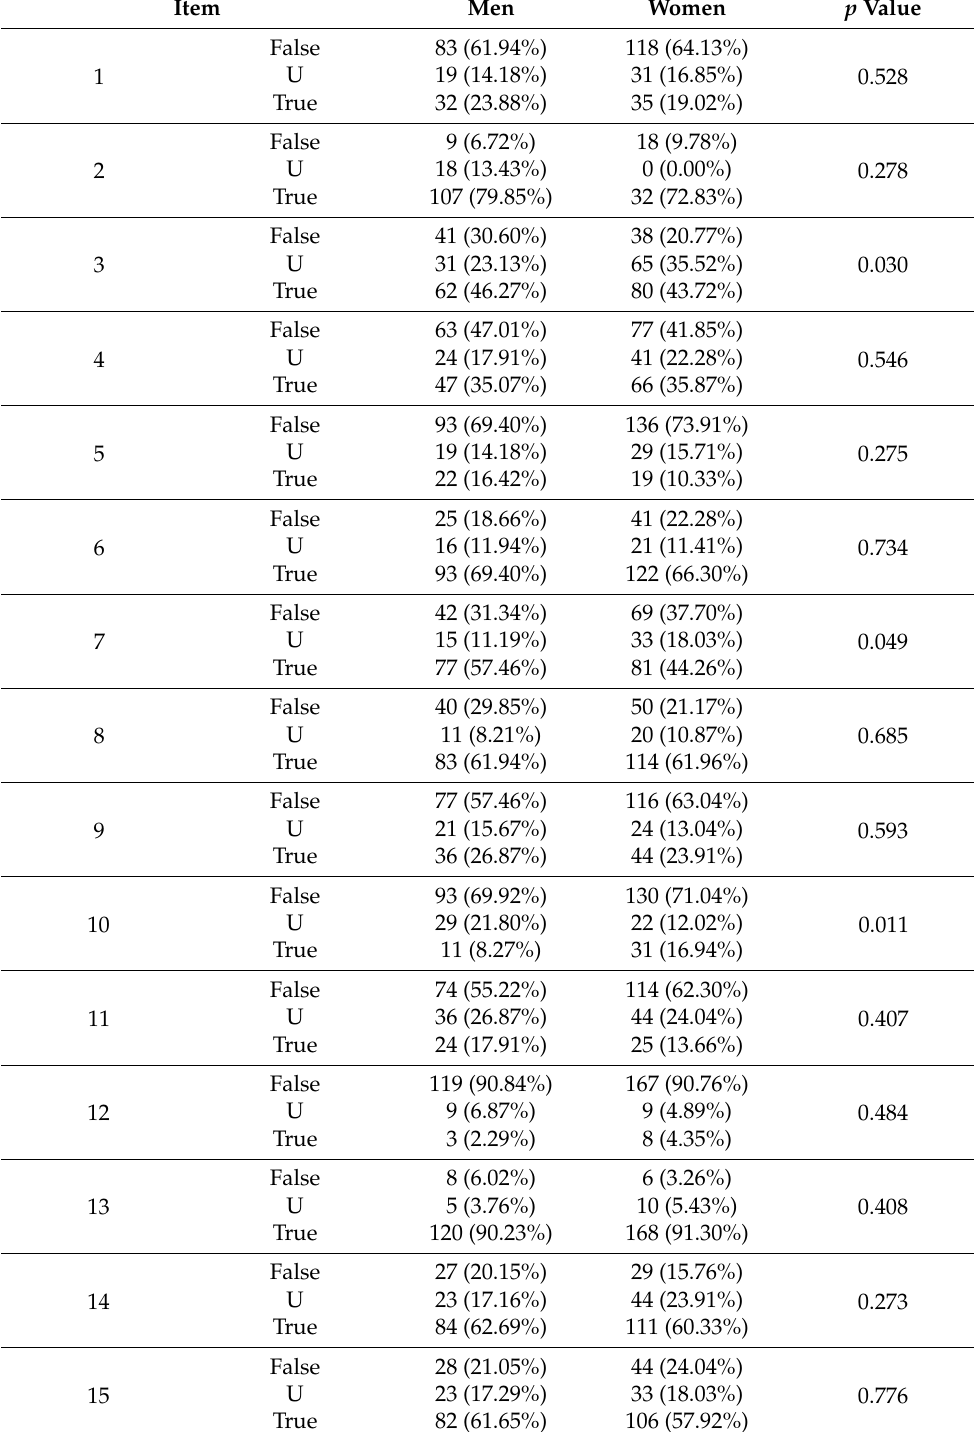
Table 5. Response to the 15 items of the questionnaire stratified by